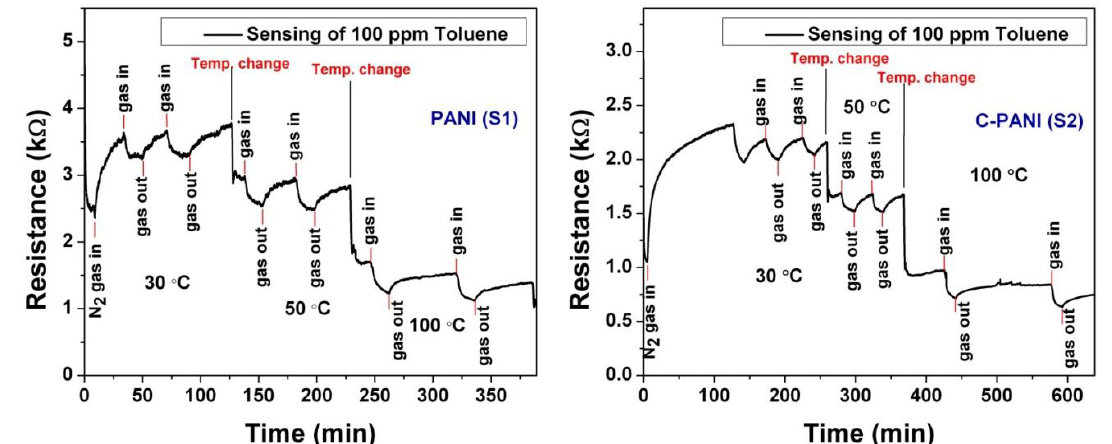
Figure 6. The toluene sensing behavior of PANI (S1) and C-PANI (S2) films at different operating temperatures (30, 50 and 100